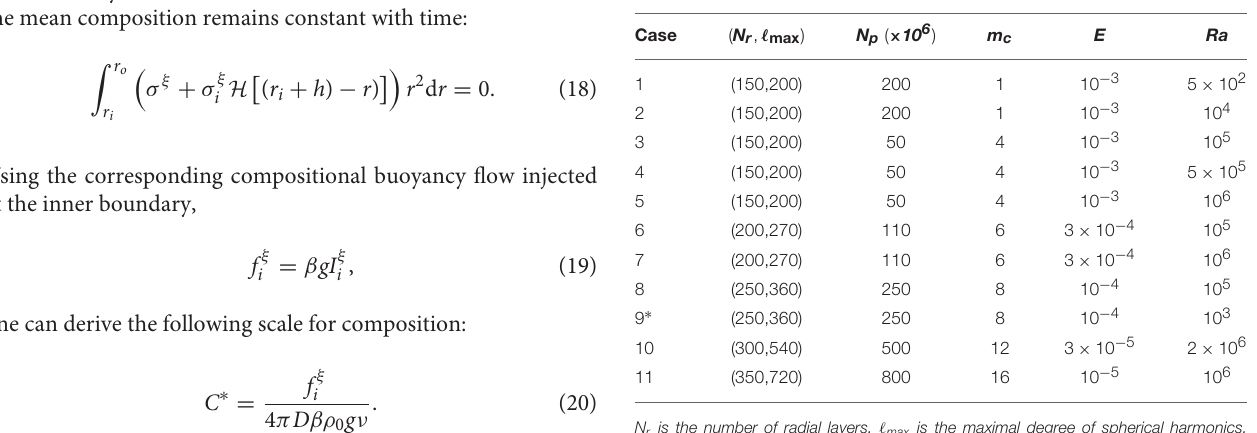
TABLE 1 | Summary of the parameters used for the different